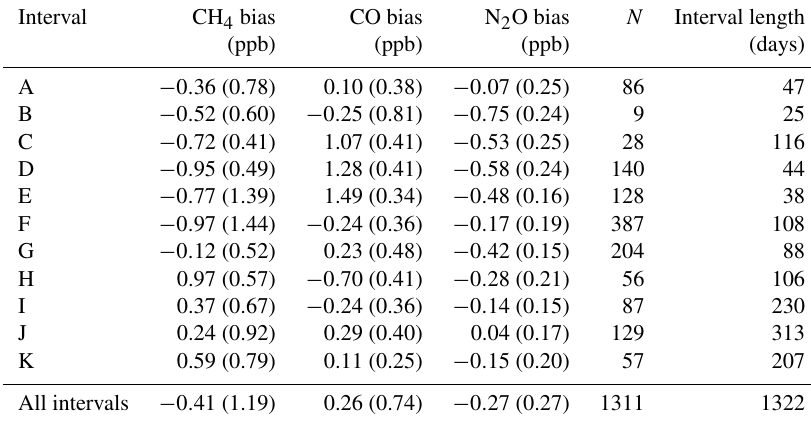
Table 5. For each interval (and total data set) in Fig. 11, the measured-to-assigned TC bias is listed. Interval reproducibility (1 σ standard deviation) is bracketed. N is the total number of TC measurements per